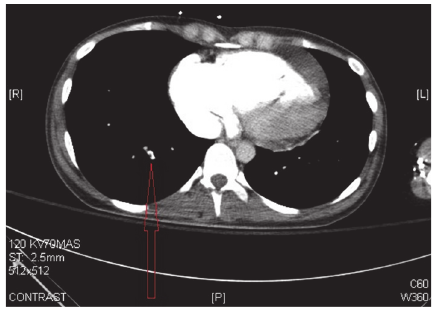
Figure 3: CT scan with contrast of the chest showing small distal right pulmonary embolus.